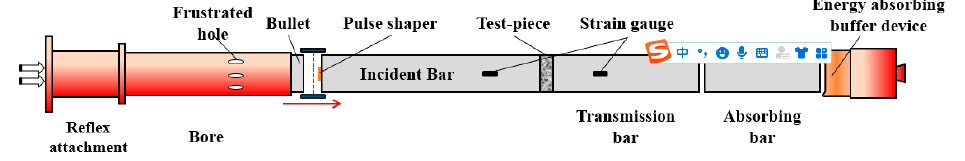
Figure 4. Schematic diagram for the dynamic test system components.